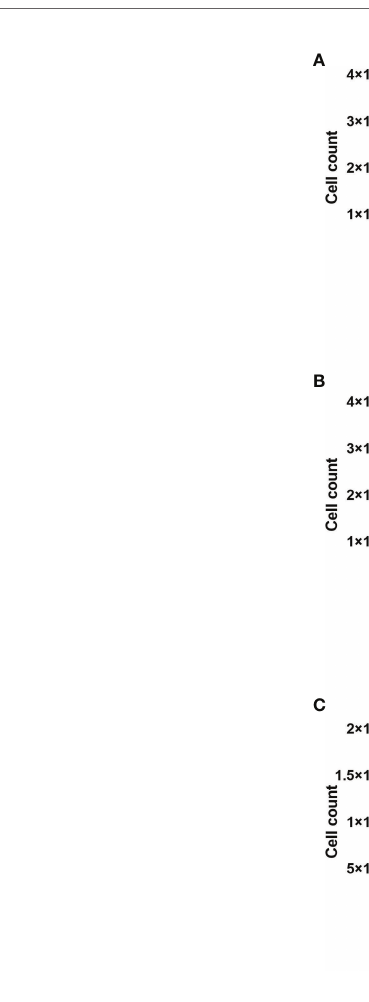
FIGURE 1 | In vitro cell growth following treatment with Cabozantinib (A) or x-rays and Cabozantinib (B) . Cells were counted 24, 48, 72 and 96h following treatment and results are derived from experiments carried out in triplicates (mean value ± SEM). Please note that curves for 10 Gy and 10 Gy + Cabozantinib cannot be distinguished due to the scale in (B) . Therefore, in (C) , the same data as in (B) are displayed in a different scale. A Two-way ANOVA (at 96h, negative controls vs. each other group) revealed signi fi cant differences to the negative controls only following irradiation ( B , *p<0.05, **p<0.01). A comparison between 10 Gy and 10 Gy + Cabozantinib revealed no signi fi cant differences at 96h (C)